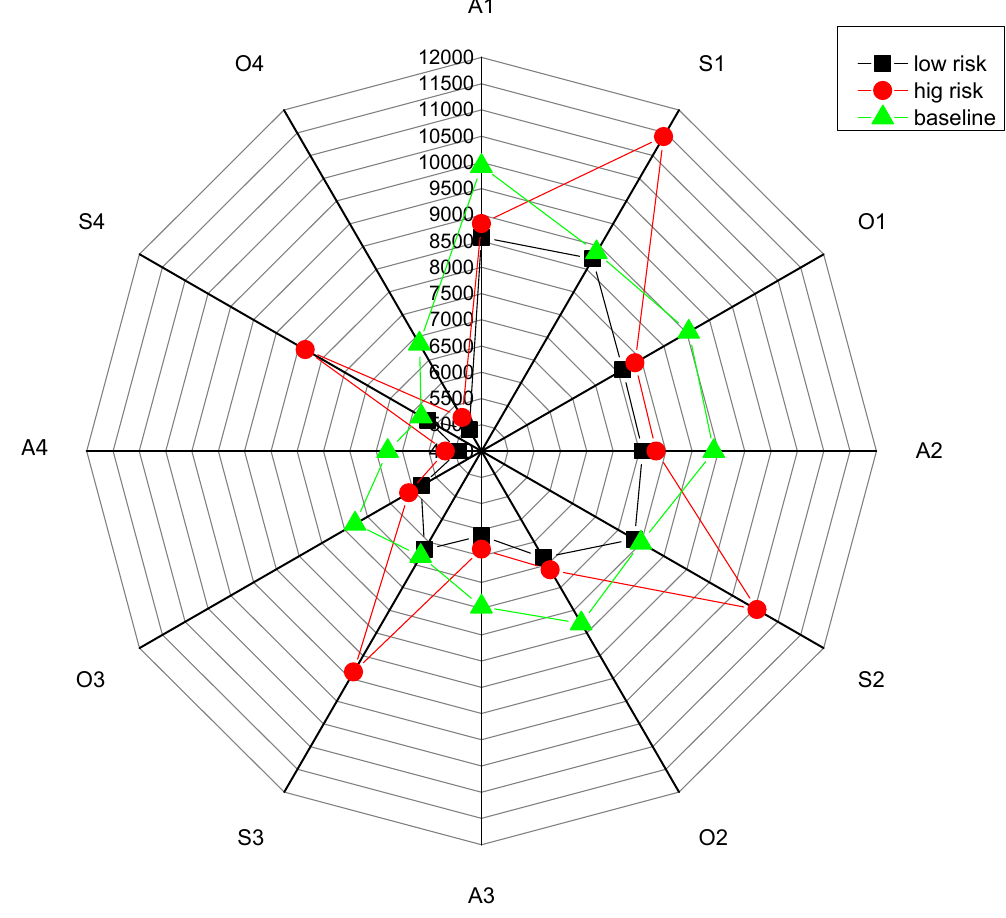
Figure 5. Carbon footprints under different N 2 O emission factors at low risk, high risk and baseline